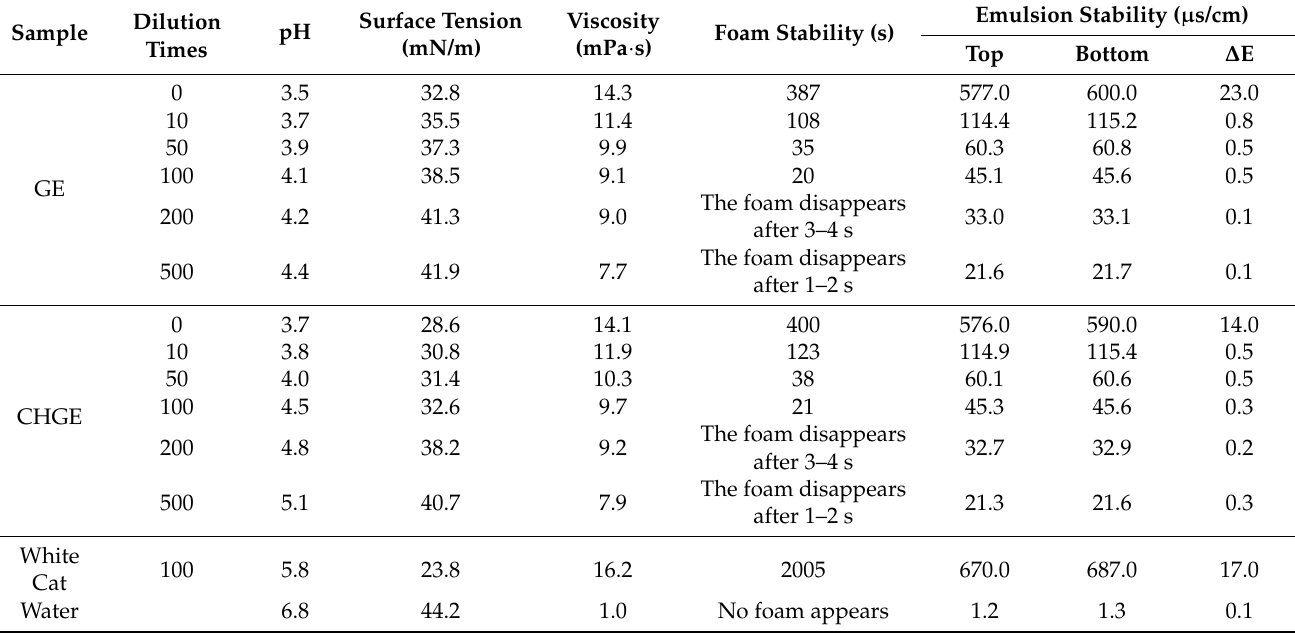
Table 2. Summary of interfacial properties of GE and CHGE at different dilutions at 25 °C. Sample